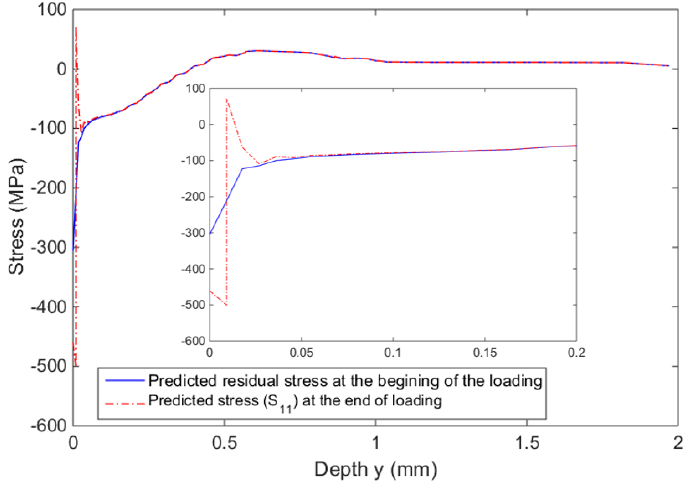
Figure 16. The predicted residual stress distribution at the beginning of the loading and the stress distribution at the end of loading without peak load and with the effect of residual.